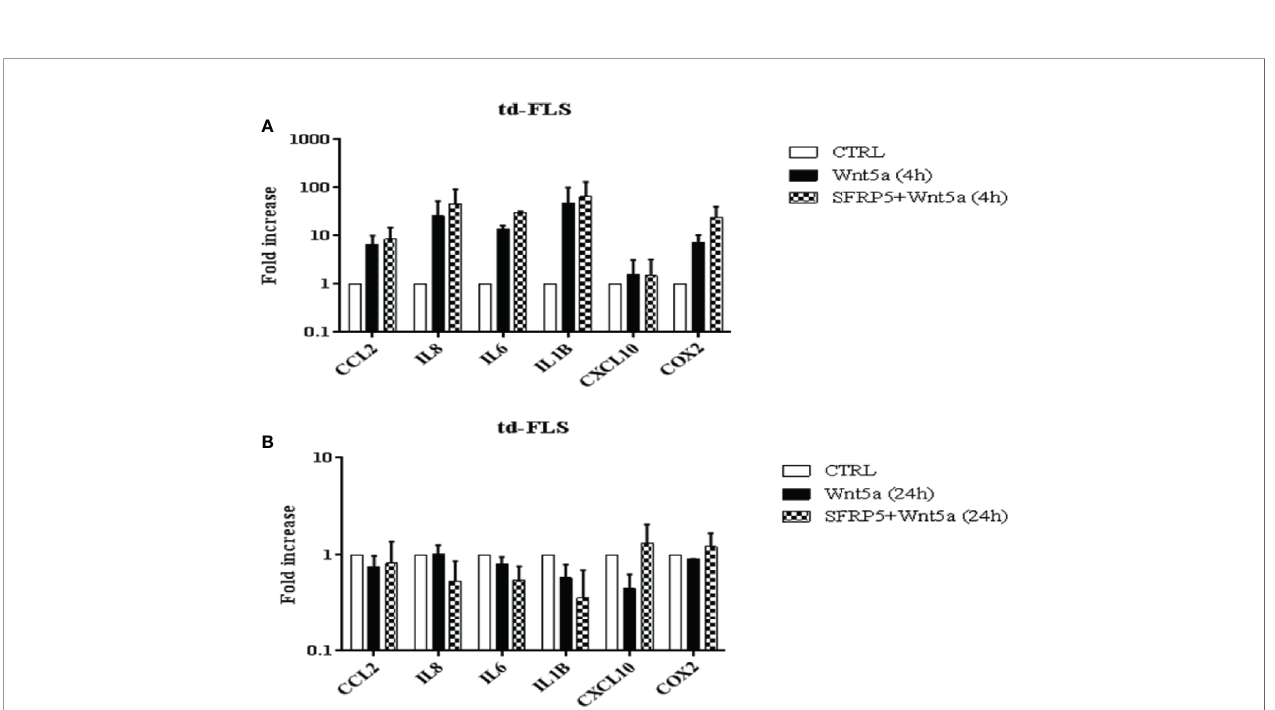
FIGURE 6 | Effect of Wnt5a on the in fl ammatory response of RA td-FLS. RA td-FLS (passage 3) were stimulated with recombinant Wnt5a (300 ng/ml) in the presence or absence of SFRP5 (1 mg/ml) for 4 h (A) and 24h (B) . Cytokine expression pro fi les (CCL2, IL8, IL1 b , CXCL10 and COX2) were determined in cell culture using qPCR. Gene expression levels in unstimulated cells were assumed to be 1. Data are means ± SD of two independent experiments each performed in triplicates using at least two different lots of each of the recombinant Wnt proteins.